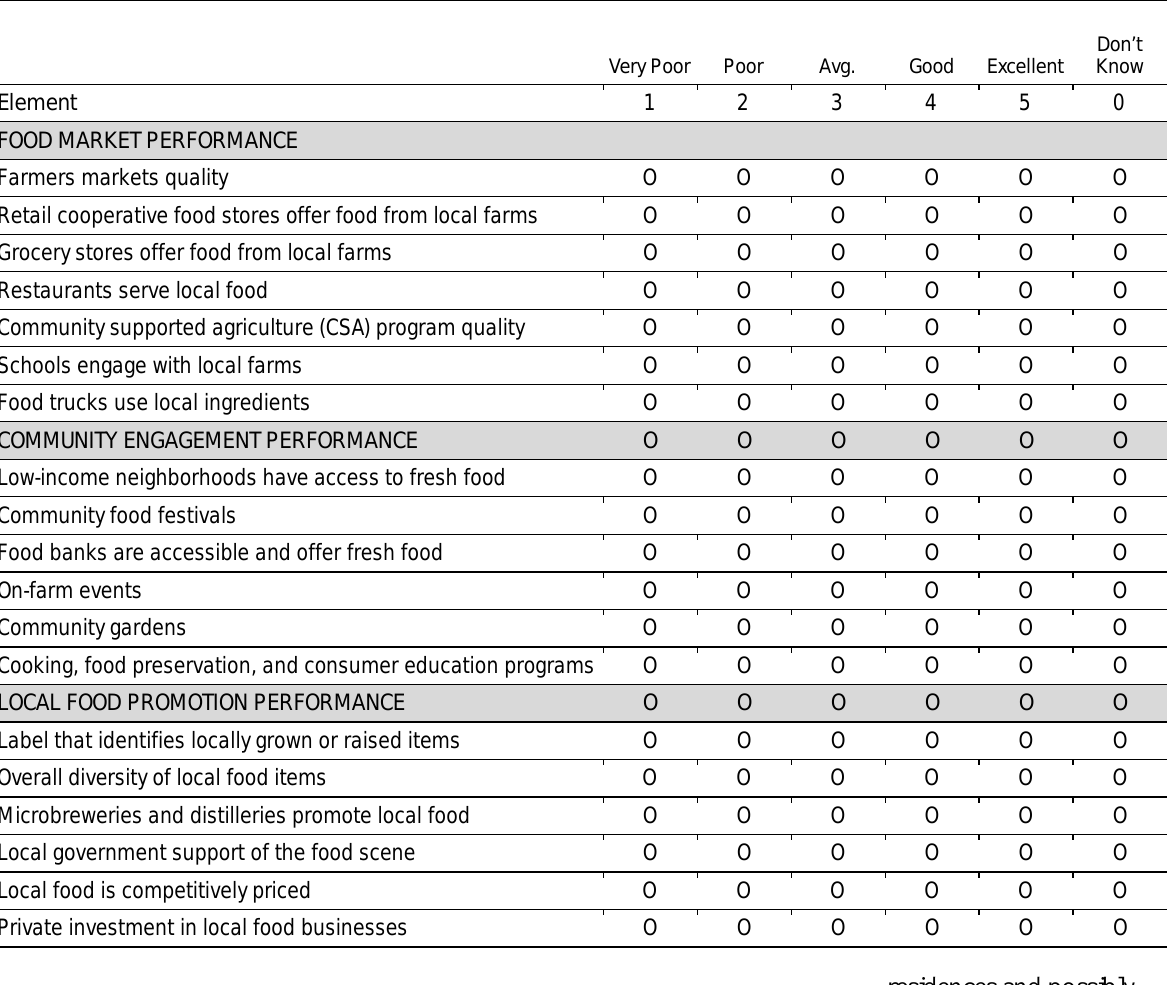
Figure 1. Individual LFS Component Rating Questions